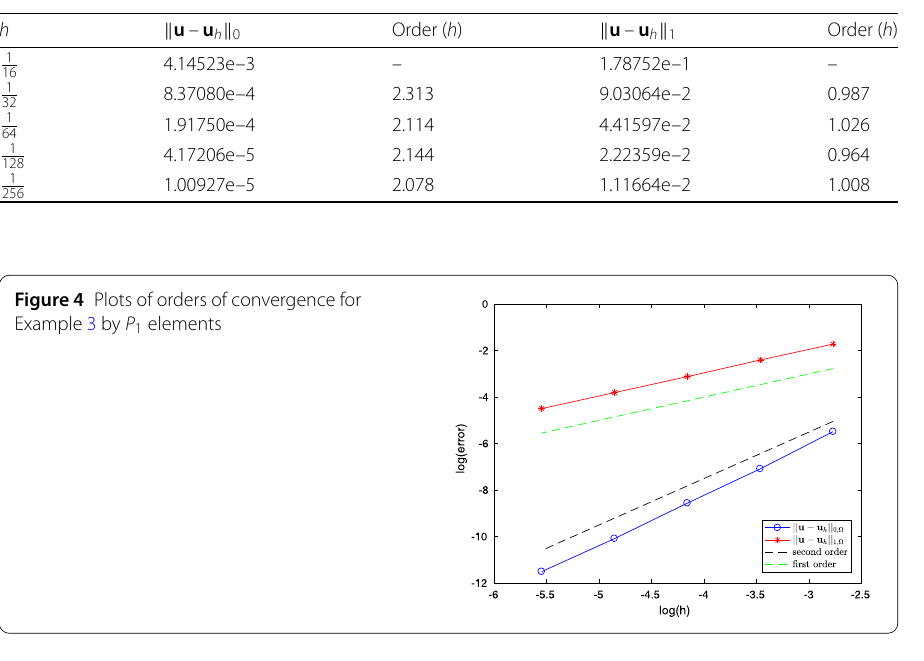
Table 3 Convergence order with respect to h of the stabilized method for Example 3 with coefficient